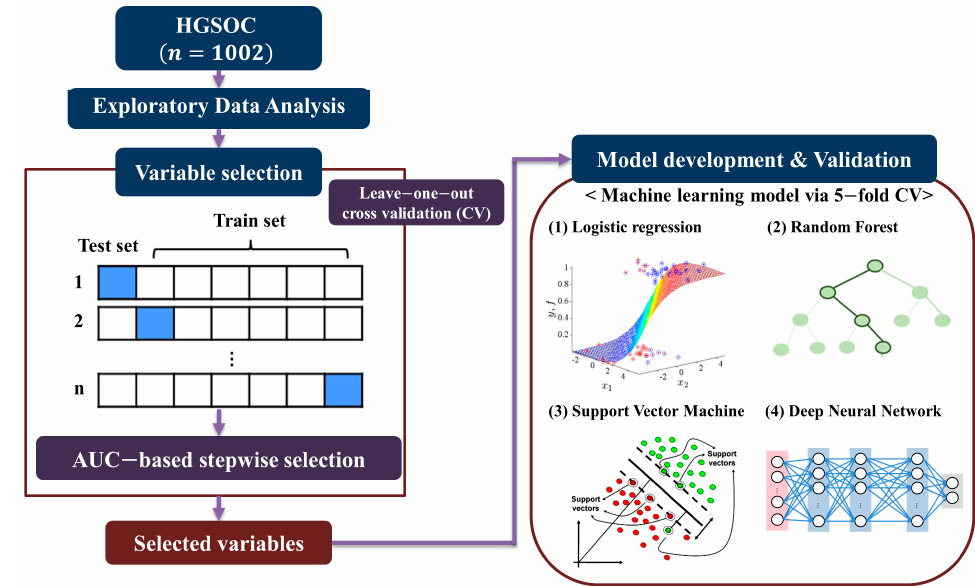
Figure 1. Overall workflow of statistical